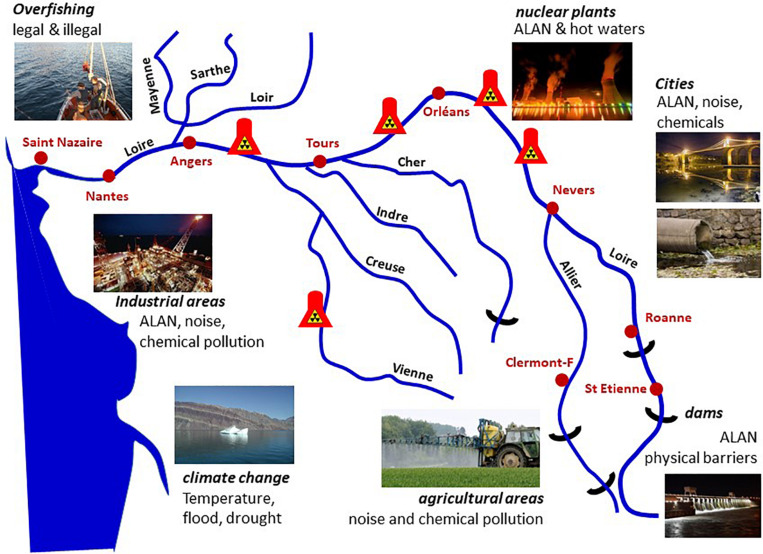
Migration is a crucial event in the Atlantic salmon, Salmo salar. In the Loire/Allier basin a ∼800 km downstream migration brings young smolts from their hatching area to the sea, where they feed and mature. In the journey they have to face light pollution (ALAN) when crossing cities or areas of active human activities (nuclear plants, industrial areas, harbours) as well as a series of other threats of anthropogenic origin, including physical barriers, overfishing, water temperature rise, physical (noise) and chemical (e.g., endocrine disruptors) pollution. They must run another 800 km back when returning to the spawning grounds. Altogether this addition of threats impacts on metabolic reactions and physiological regulation, including their rhythmic components, which have put the species in danger of extinction.